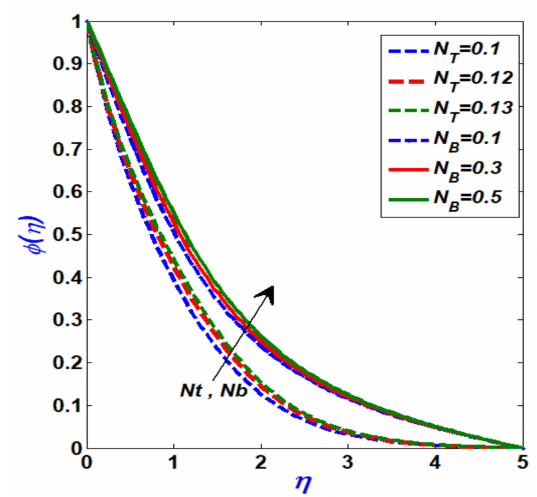
Figure 10. Concentration profile with variation in N T , N B